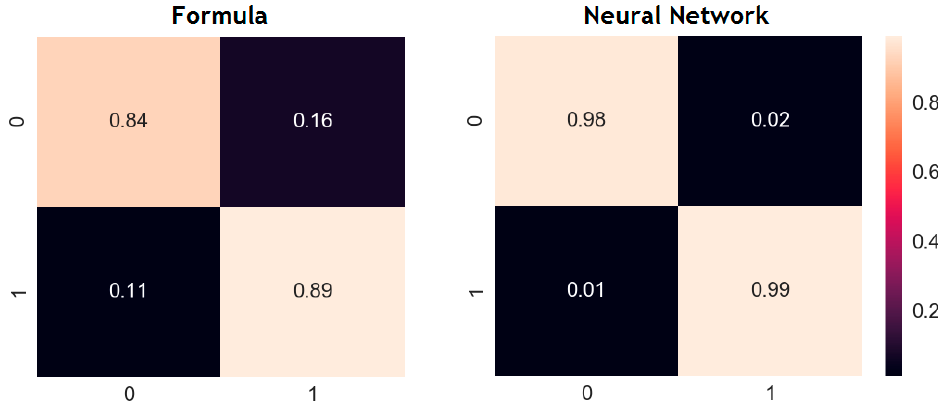
Figure 14. Comparison of the neural network approach with the traditional.